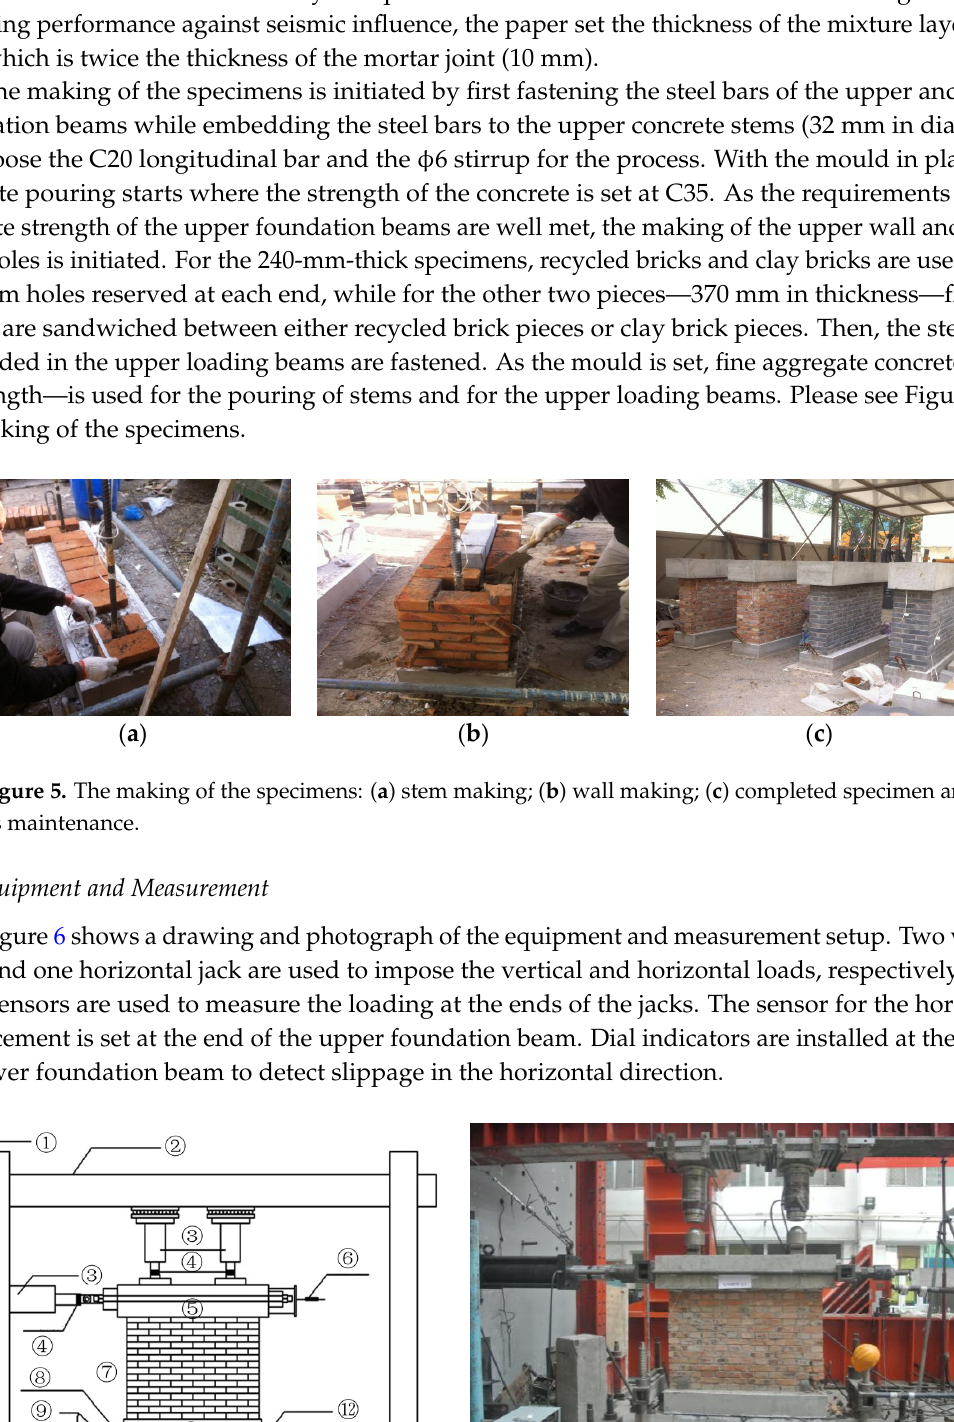
( c ) Figure 7. The loading approach: ( a ) preliminary deformation stage; ( b ) isolator slippage stage; ( c ) seismic resistance of the wall stage. 2.3. Material and Performance Indicator The MG isolator, i.e., the layer consisting of the marble and graphite mixture, performs best when the volume ratio of marbles to graphite is 5:2, and the quality ratio is 5:1. Figure 8 shows photographs of the MG mixture and the MG isolator in place. ( a ) ( b ) Figure 8. MG isolator: ( a ) MG mixture; ( b ) MG isolator in place. Tables 1 and 2 present the main characteristics of the marbles and graphite.